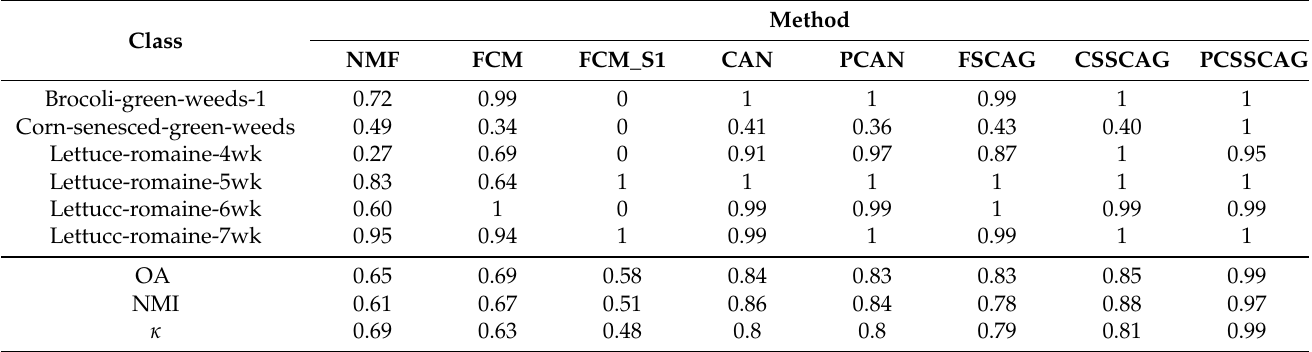
Table 2. Clustering accuracy of each category, OA, NMI, and κ of different clustering methods on